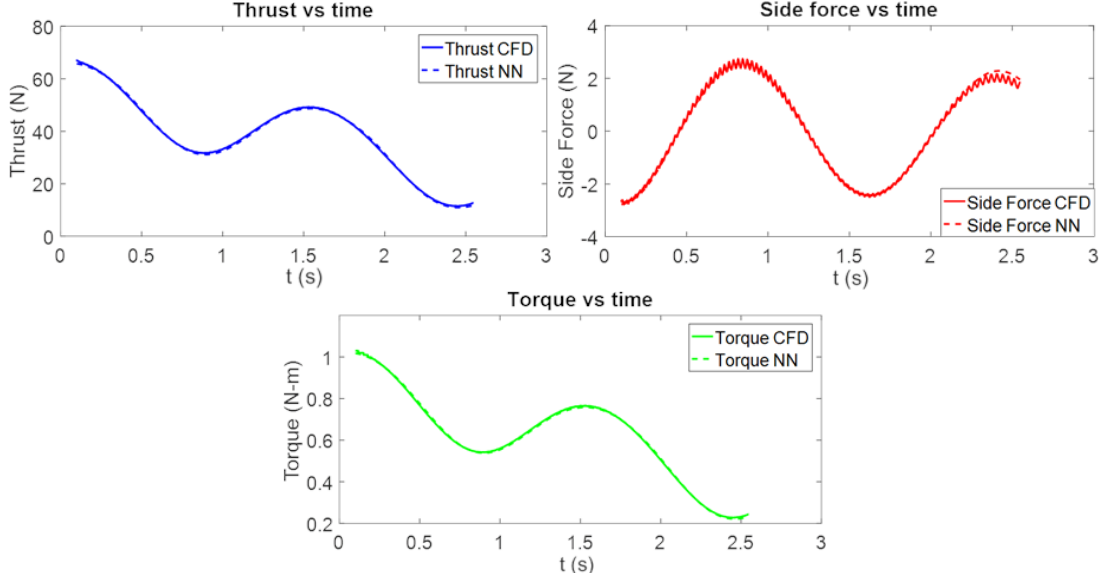
Figure 9. Open water thrust, side force, and torque for the test data set as a function of time comparing CFD to the neural